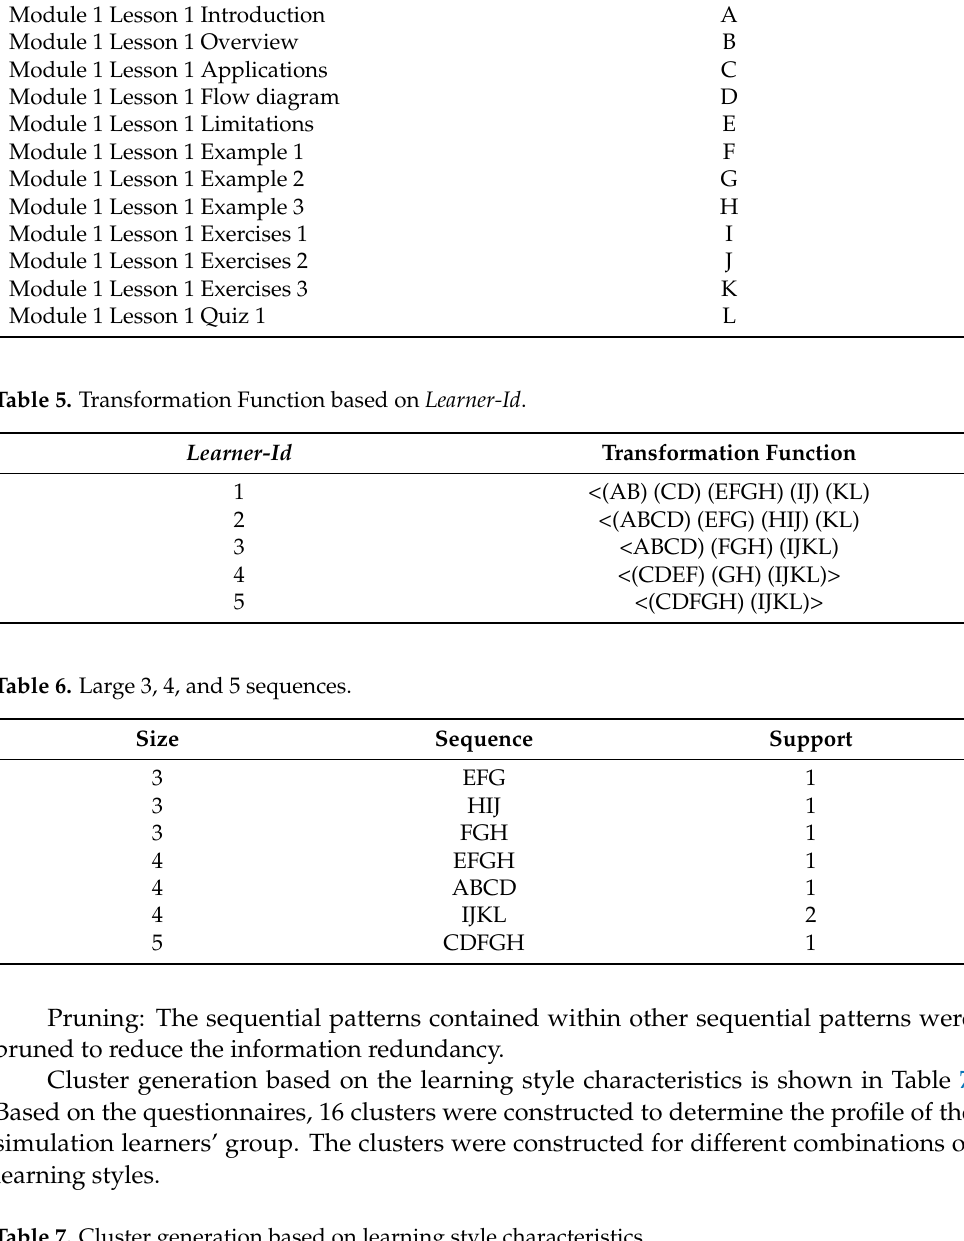
Table 7. Cluster generation based on learning style